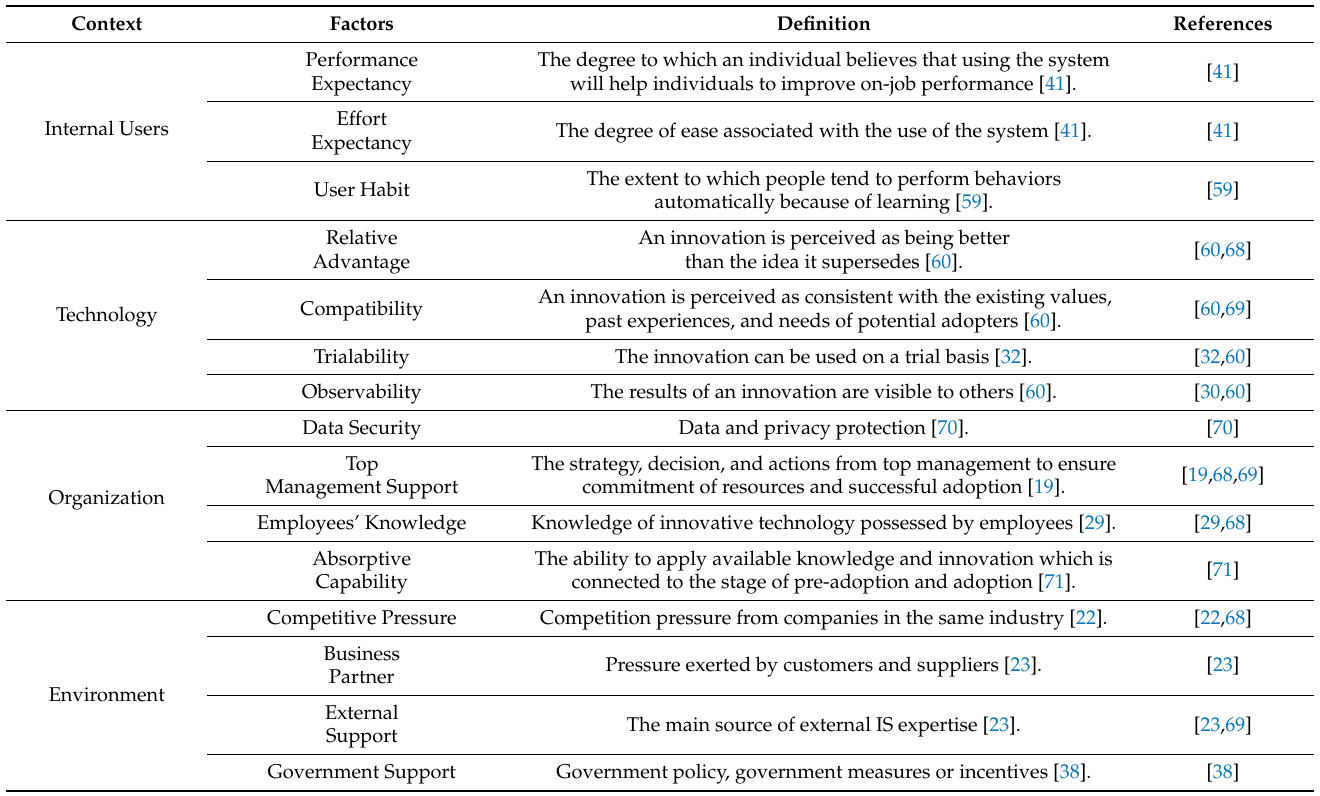
Table A2. Findings Factor definition and reference.